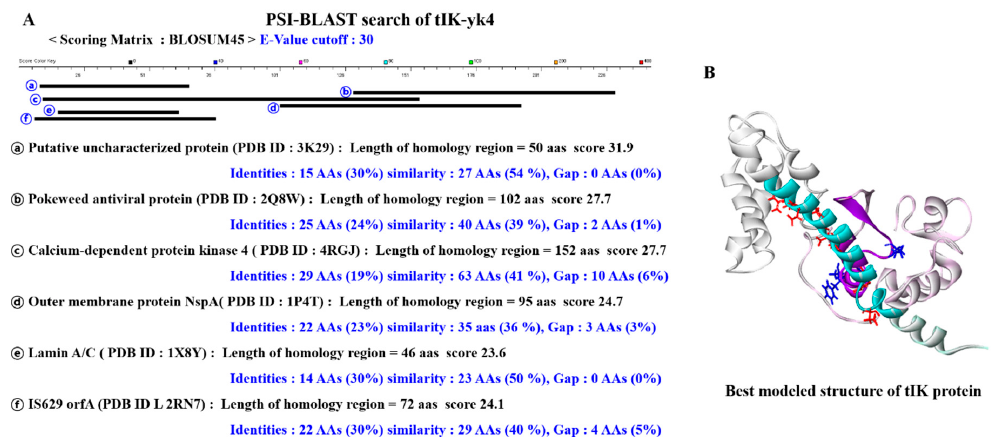
Figure 1. 3D structure of tIK by computational simulation. ( A ) When performing with the Position-Specific Iterative Basic Local Alignment Search Tool (PSI-BLAST), BLOSUM45 was used as the scoring matrix and the E-value cutoff was 30. Based on the high scores, six highly homologous proteins were identified and these templates are represented from ⓐ to ⓕ . Of the six templates, ⓑ , ⓒ , and ⓕ that can encompass the full sequence of tIK were selected, and the 3D structure of the tIK protein obtained from this is shown in ( B ).